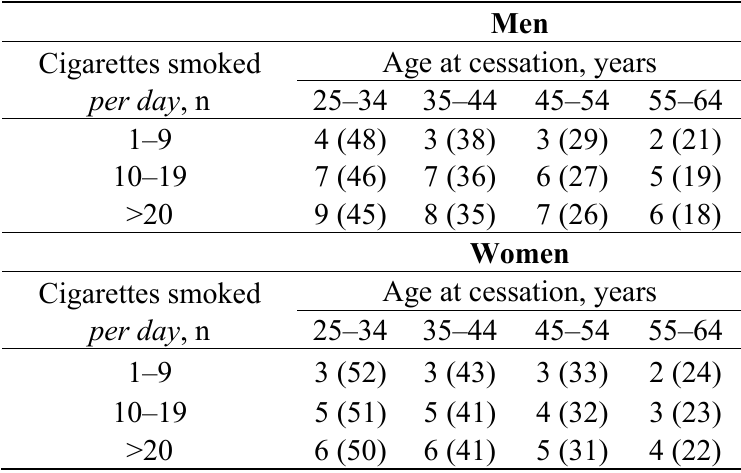
Table 1. Number of years of life gained and life expectancy if continuing smoking (in parenthesis) by age at smoking cessation, number of cigarettes smoked per day and